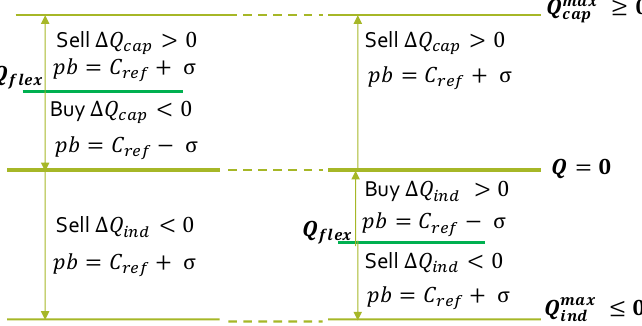
Figure 6. Bids to buy and to sell depending on the reactive operating point of flexible resources.